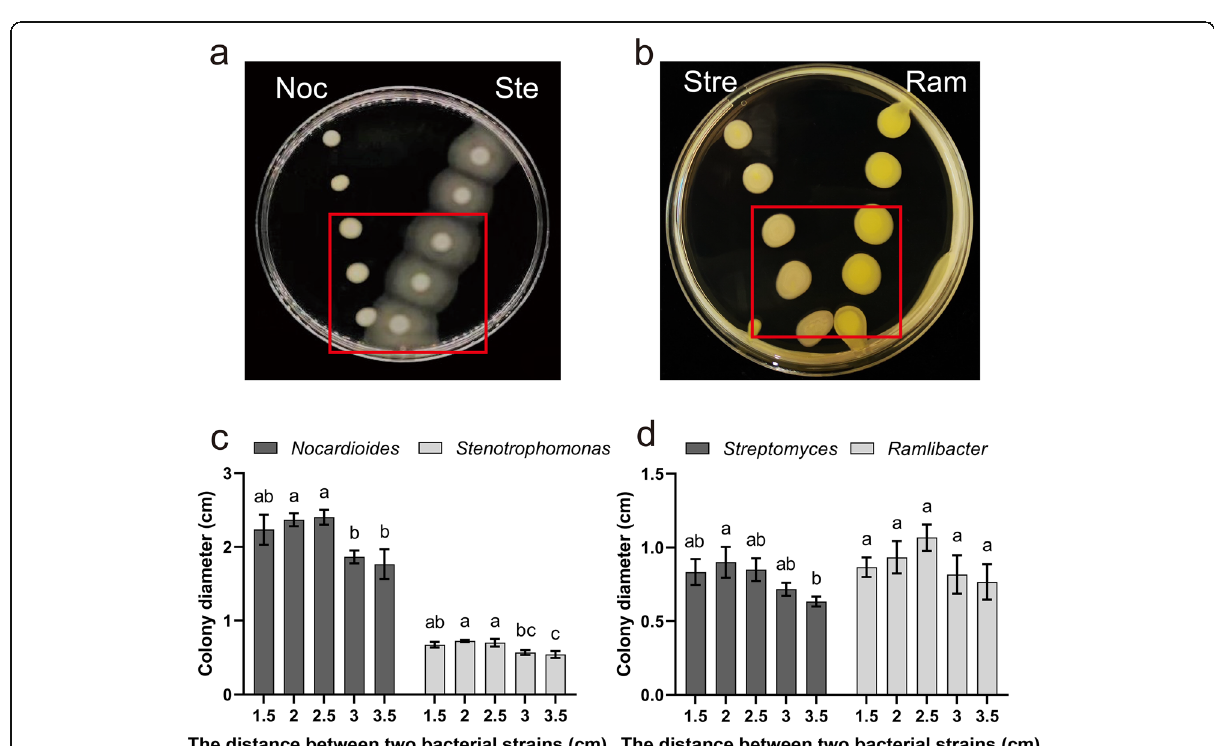
Fig. 8 Validation of network correlations under α -terpineol fumigation. a and c The synergistic effects of growth promotion between Nocardioides (directly enriched by α -terpineol) and Stenotrophomonas (indirectly enriched by α -terpineol). b and d The synergistic effects of growth promotion between Ramlibacter (directly enriched by α -terpineol) and Streptomyces (indirectly enriched by α -terpineol). Data are presented as the mean ± SE, bars indicate SE, and different letters indicate significant differences analyzed by one-way ANOVA with Duncan ’ s multiple range test, P < 0.05. Noc, Nocardioides ; Ste, Stenotrophomonas ; Stre, Streptomyces ; Ram,